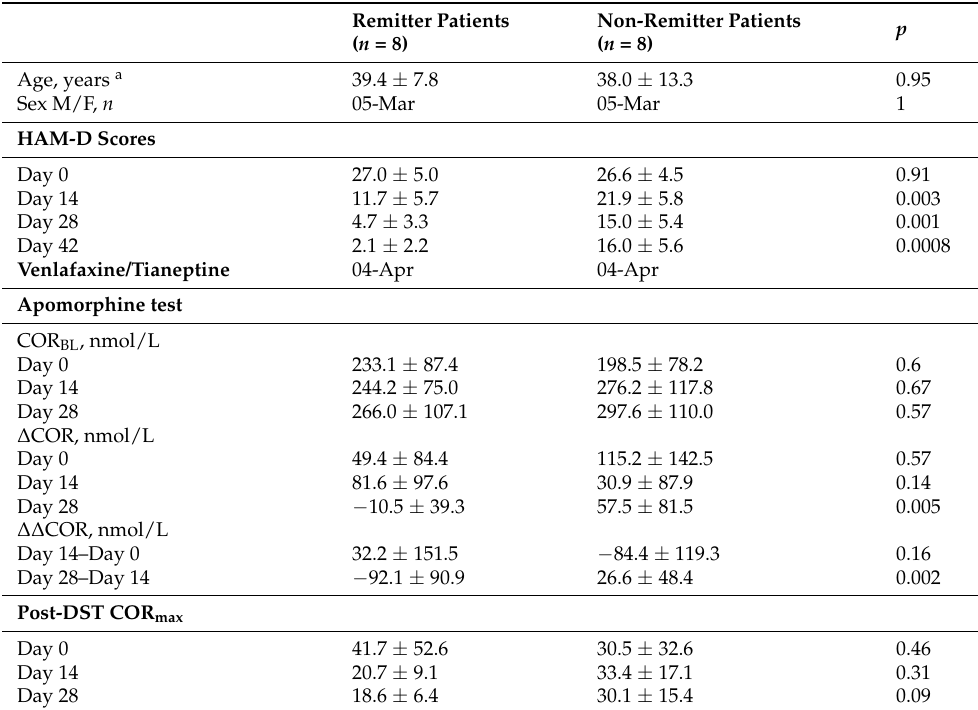
Table 2. Bio-clinical data of depressed groups defined by antidepressant treatment responses.